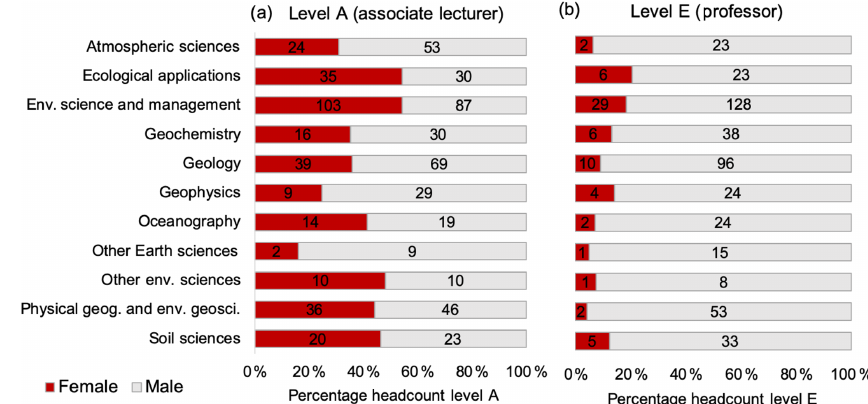
Figure 2. Percentage headcount by four-digit Field of Research (FoR) code within the two-digit Fields of Research for Earth Sciences (FoR 04) and Environmental Sciences (FoR 05) reported by the Australian Research Council (ARC) Excellence in Research for Australia (ERA) 2018 evaluation (Australian Research Council, 2019). (a) Percentage headcount at Level A (Associate or Assistant Lecturer/Research Associate). (b) Percentage headcount at Level E (Professor).